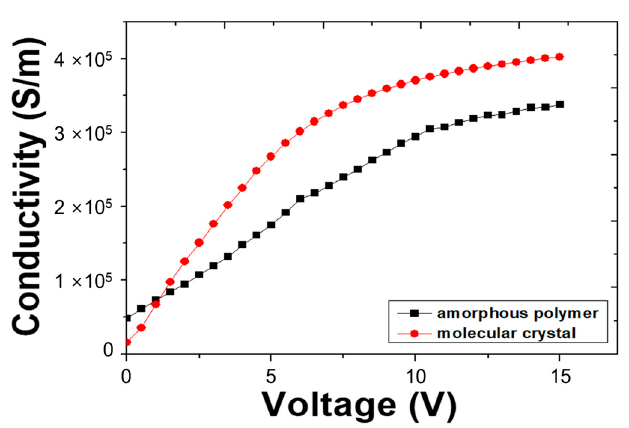
Figure 7. Conductivity of MEH-PPV film at 75 Hz by LCR meter.